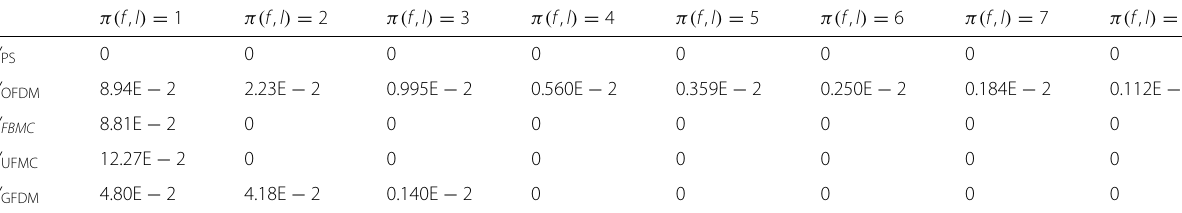
Table 1 Interference vector table of different candidate waveforms in